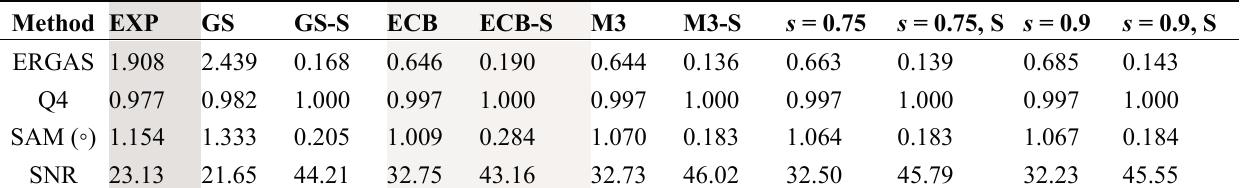
Table 7. Quantitative comparison of the fusion results after degrading the images into the LR resolution, i.e ., at 8.0 m, to check the consistency property of the Wald’s protocol for the WorldView-2 group 1 dataset at the reduced